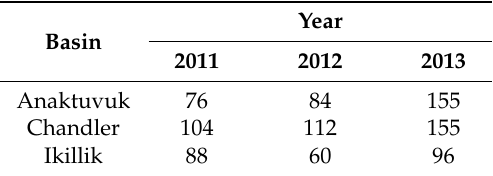
Table 3. Basin average snow water equivalent in mm.